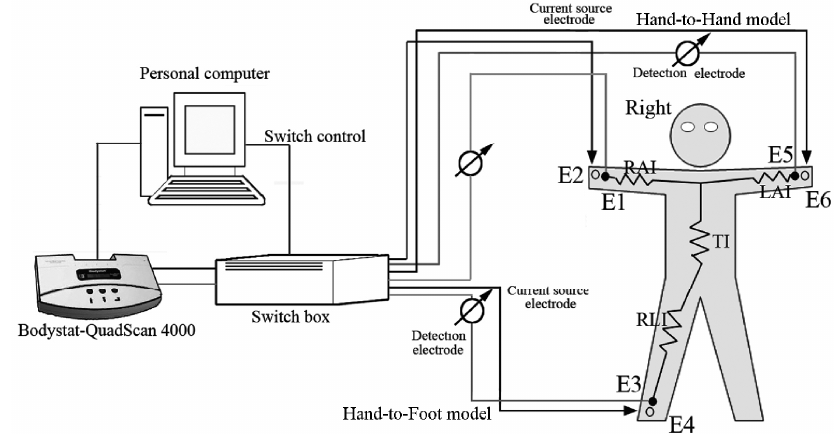
Figure 2. Impedance measurement system. E1, E3, and E5 were measuring electrodes, and E2, E4, and E6 were current electrodes. After forming the circuit between E2 and E4, the measurement of E1 and E3 yielded the hand ‐ to ‐ foot impedance: RAI + TI + RLI (Z HF ). Similarly, the circuit between E2 and E6 and the measurement of E1 and E5 yielded the hand ‐ to ‐ hand impedance: RAI + LAI (Z HH ). RAI, right arm impedance; TI, trunk impedance; LAI, left arm impedance; RLI, right leg impedance. We used the detector electrodes (E1, E3) and current source electrodes (E2, E4) to form a measurement circuit. After measuring hand ‐ to ‐ foot model impedance, we canceled the E3, E4 function located at the lower right foot and activated the E5, E6 at the right handle and retained the E1, E2 function, forming another measurement loop to obtain the hand ‐ to ‐ hand impedance model. Both hand ‐ to ‐ foot or whole body models were created by adding the arm, trunk, and leg impedance values